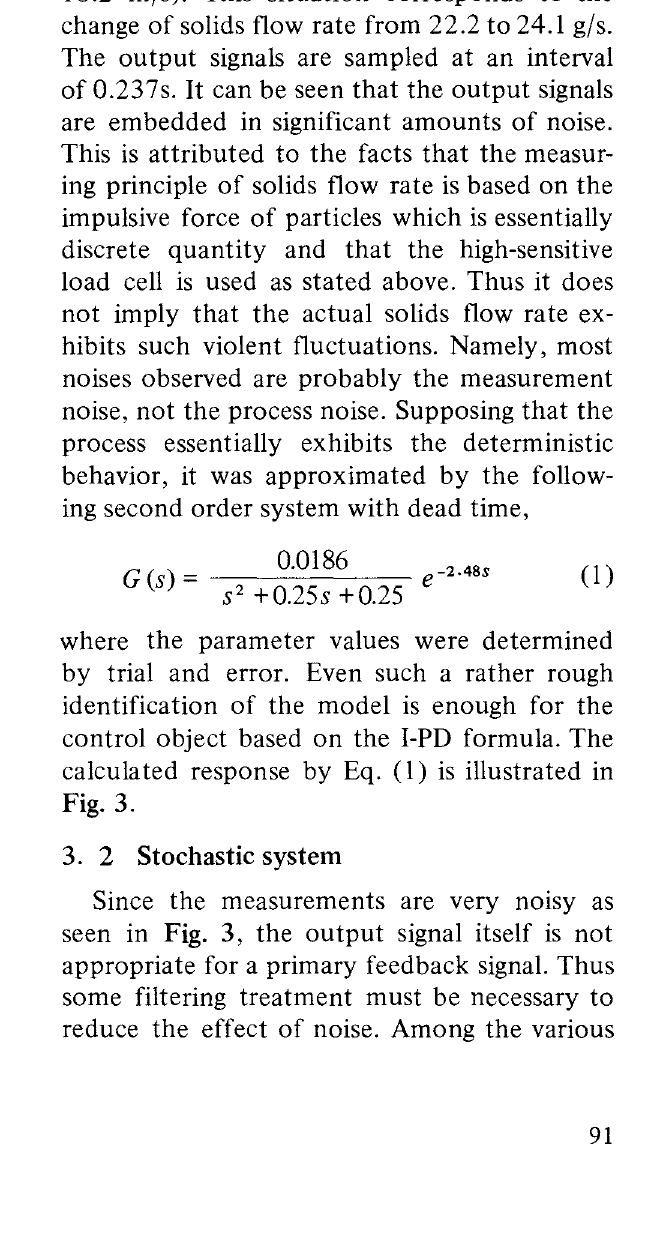
Fig. 2 Relationship between input (pulse number of rotary encoder), and average of system output (output voltage from load-cell) and solids flow